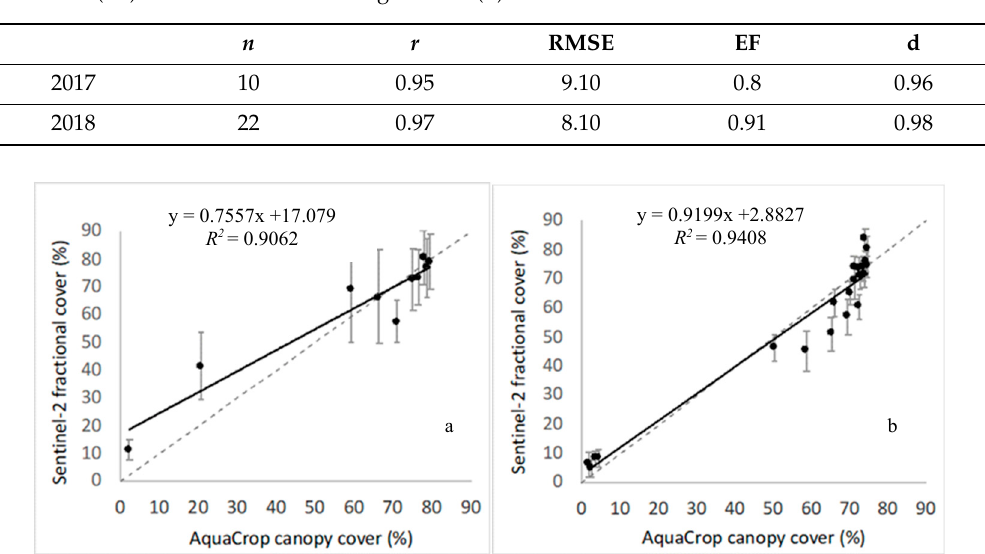
Figure 5. Linear correlation between tomato canopy cover simulated by AquaCrop and fractional cover retrieved by Sentinel-2 imagery in 2017 ( a ) and 2018 ( b ). Standard deviation (bars) and 1:1 line (dashed line) are reported.